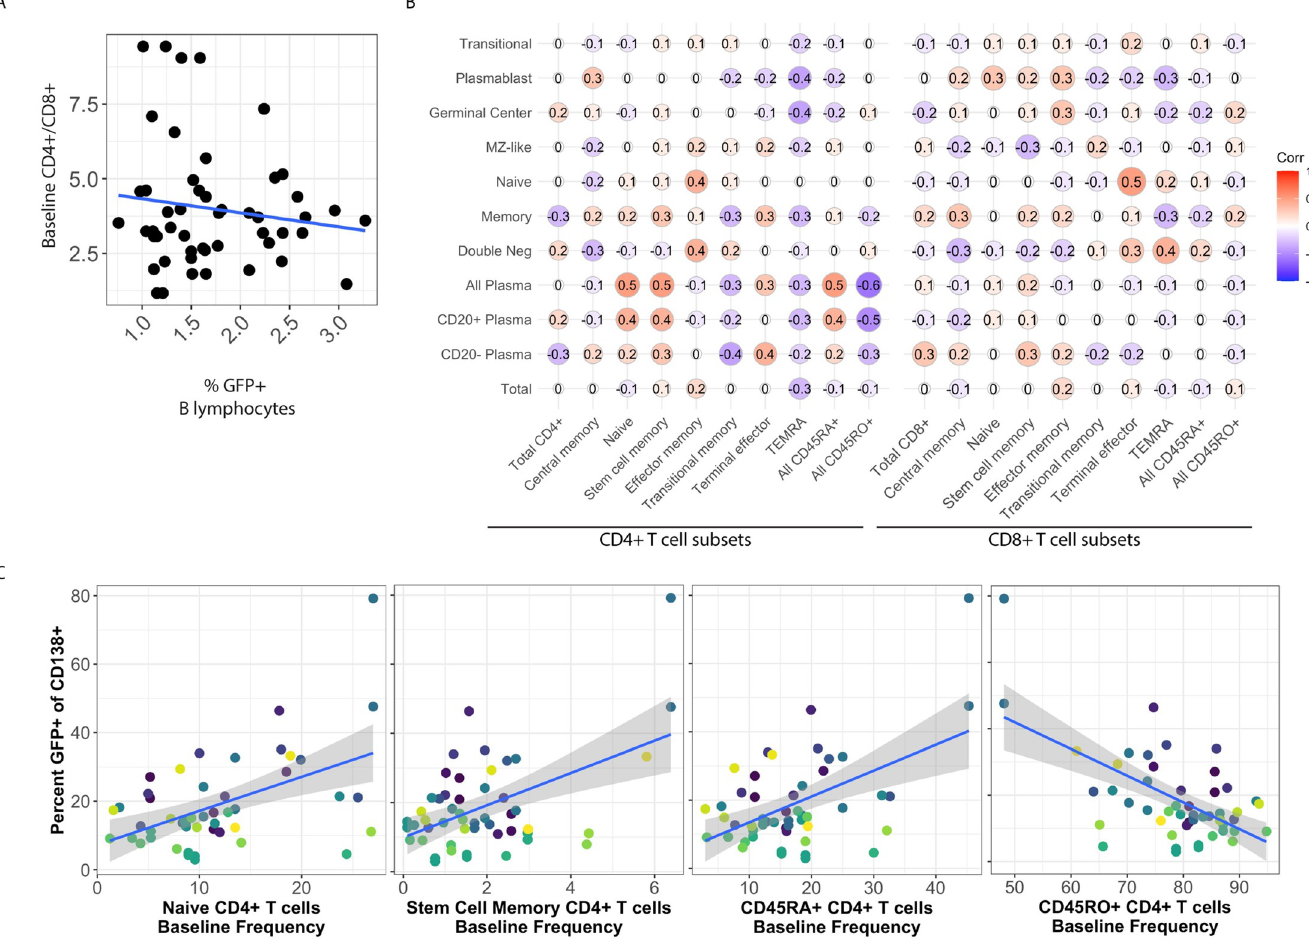
Fig 5. The donor-specific CD4+ T cell microenvironment influences infection of CD138+ plasma cells. (A) For each donor, baseline levels of CD4+ T cells/CD8+ T cells is plotted against the overall susceptibility of the specimen based on the percent of GFP+ B lymphocytes at 3 dpi. Blue line indicates least means linear regression. Correlation analysis reveals no significant linear or monotonic relationship between the variables. (B) Pairwise linear correlations (Pearson method) were performed for overall (Total) and lineage-specific KSHV infection at 3 dpi (vertical axis) and baseline T cell subsets as defined in S1 Fig and Table 2. Power analysis reveals that the data set can predict significant correlations at the level of p > |0.4| with alpha = 0.05 and power = 0.8. (C) Scatter plots of significant correlations from (B) between the baseline frequency of CD4+ T cell subsets (x-axis) and KSHV infection of CD138+ plasma cells (y-axis). Blue lines indicate least means linear regression and grey shading is standard error. Colors indicate unique tonsil specimens and can be compared across panels within the